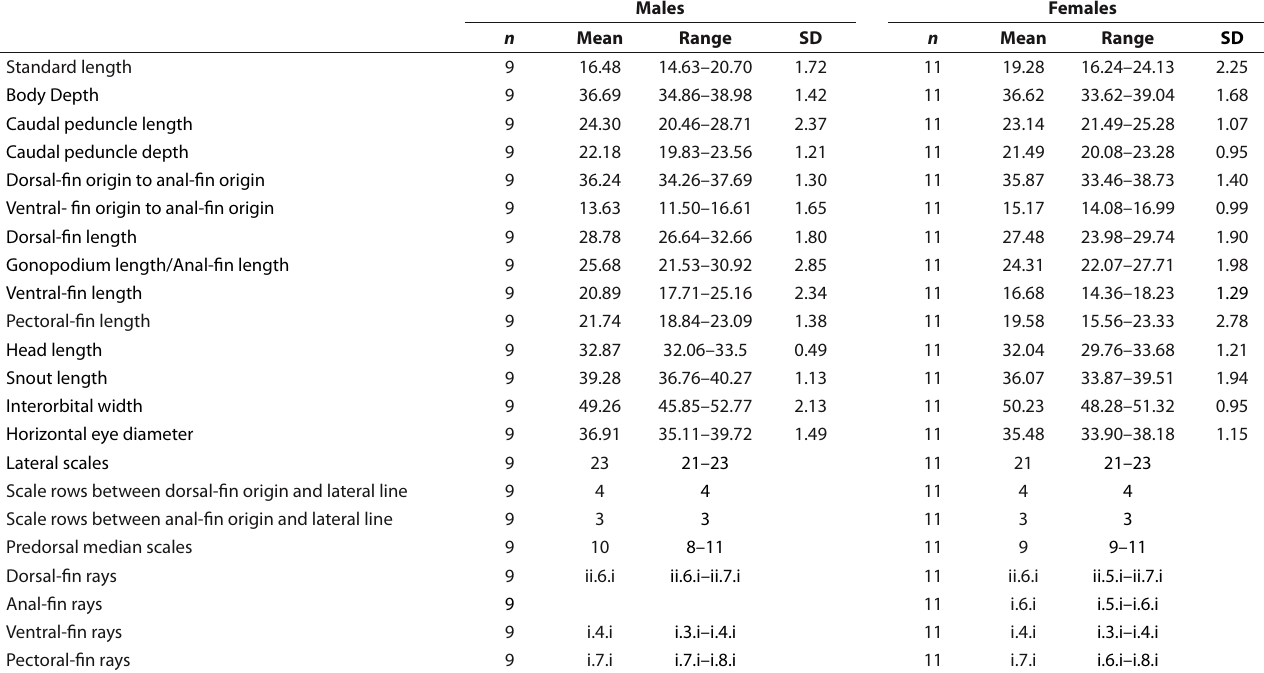
Table 2. Morphometric (mm) and meristic values for specimens of Xiphophorus maculatus from the Azuceno Wetland, Guamo municipality, Tolima Department,